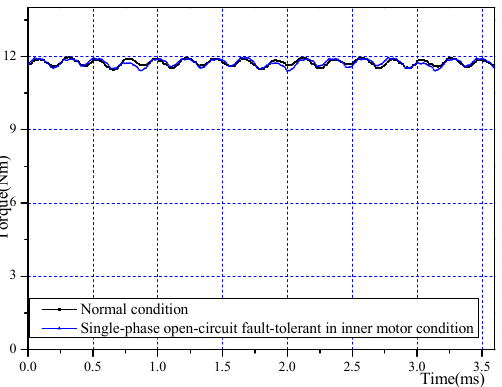
Figure 16. Torque waveform of outer motor when inner motor is working under different conditions.